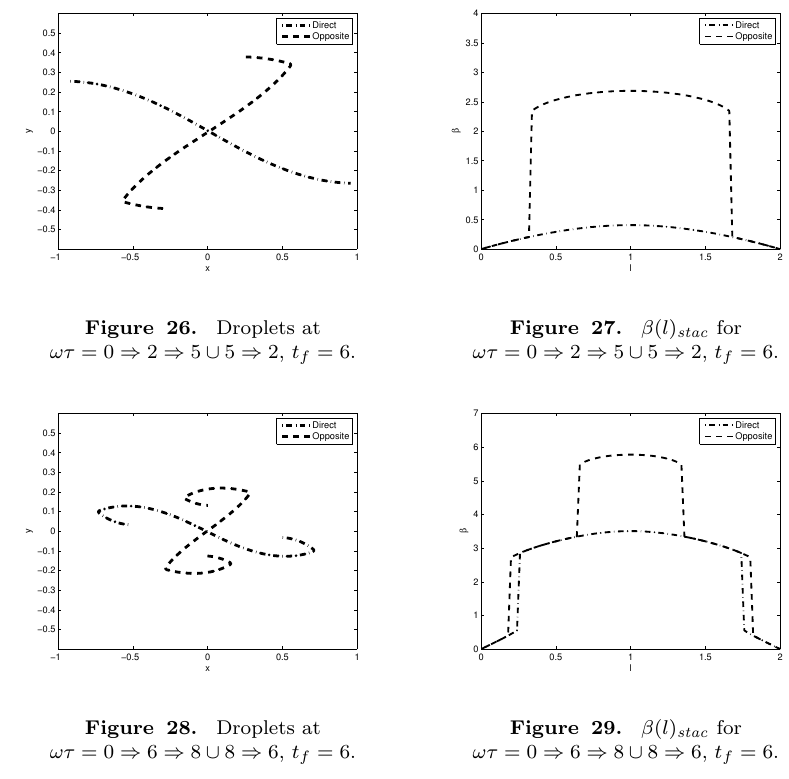
Figure 28. Droplets at ωτ = 0 ⇒ 6 ⇒ 8 ∪ 8 ⇒ 6, t f = 6.